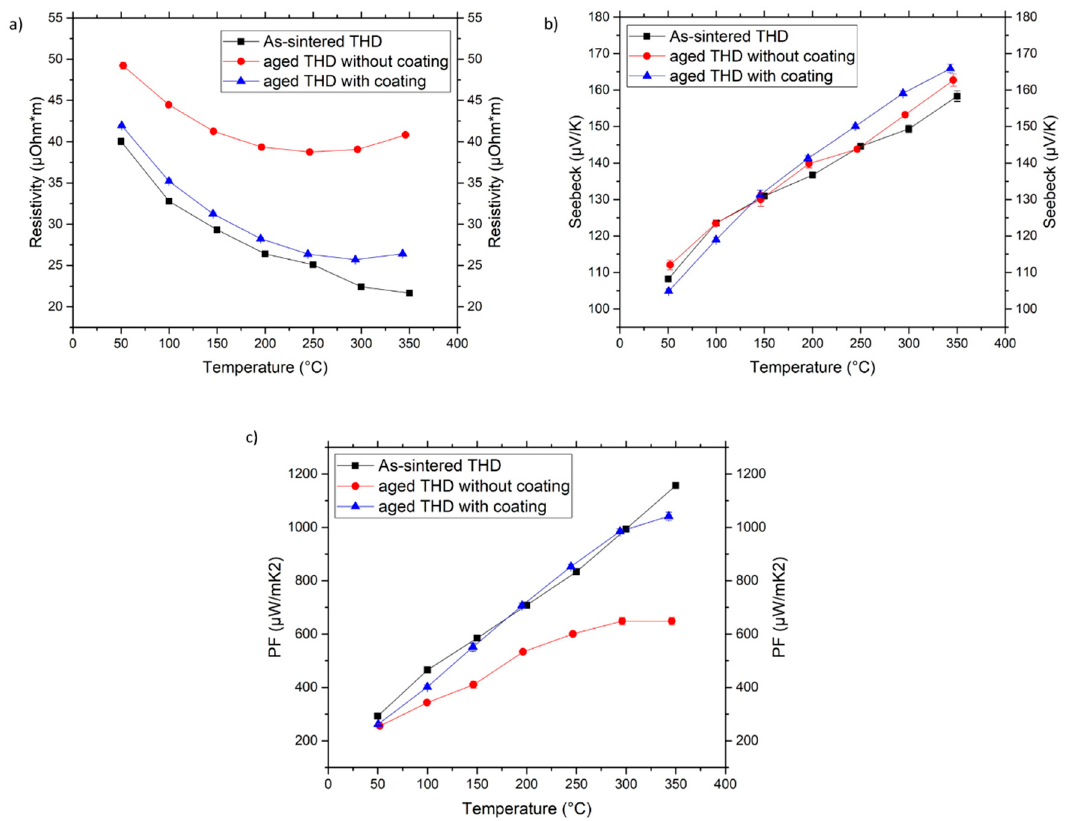
Figure 10. Temperature dependence of the ( a ) Electrical resistivity ( b ) Seebeck coefficient and ( c ) Power Factor of as-sintered THD and aged THD, with and without coating after ageing at 350 °C for 48 h.